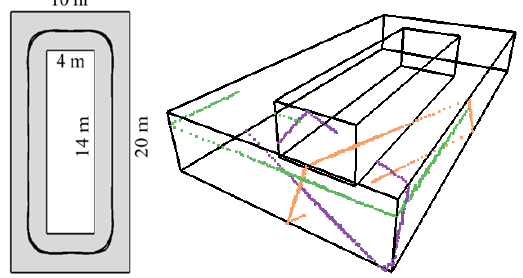
Figure 3. Corridor with a loop. Left: floor plan with dimensions and path. Right: 3D view with one scan of the three